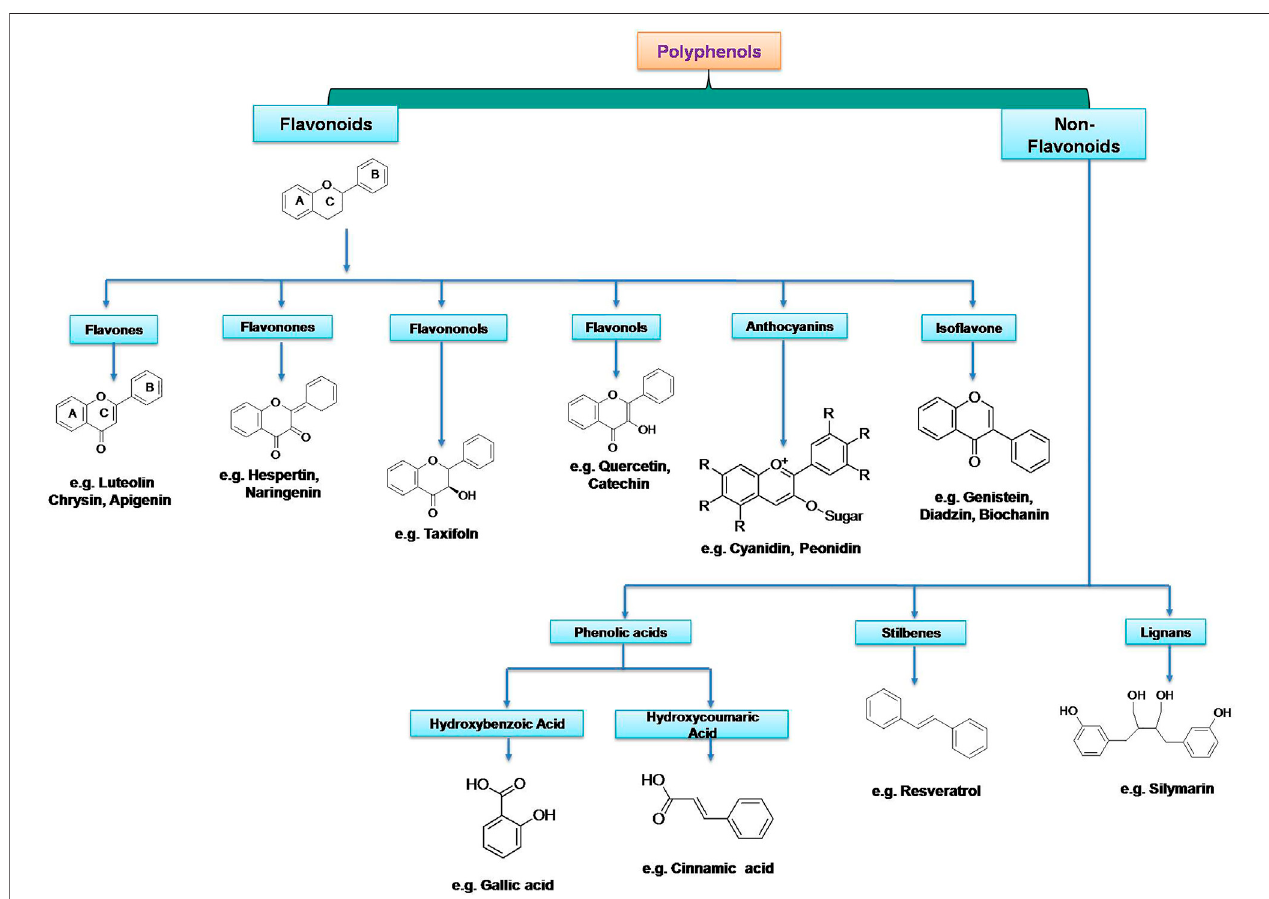
FIGURE 3 | Different classes of plant polyphenols with their basic structural scaffolds. Structural scaffolds represent the chemistry behind various classes of polyphenolic substances.